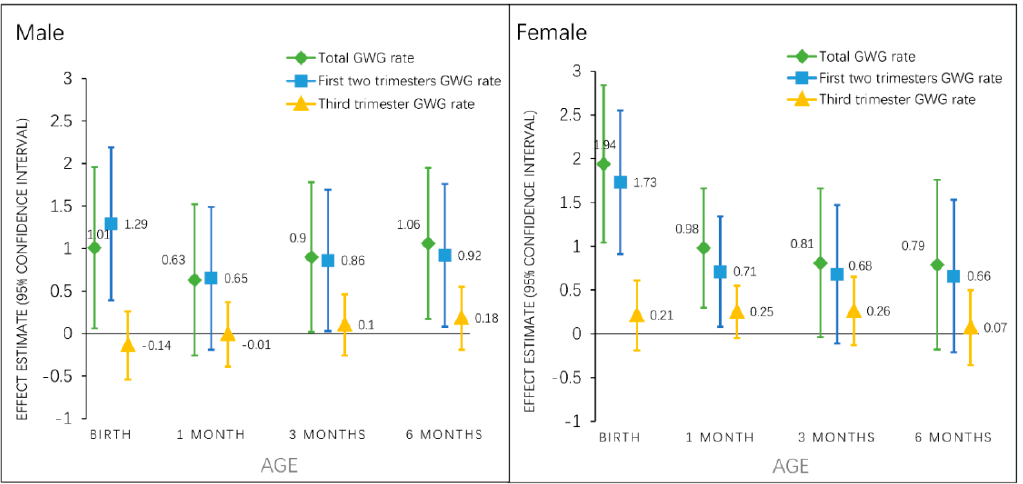
− 0.28 ( − 0.57, 0.01) Adjusted for pre-pregnancy body mass index, maternal age, race, parity, education, household